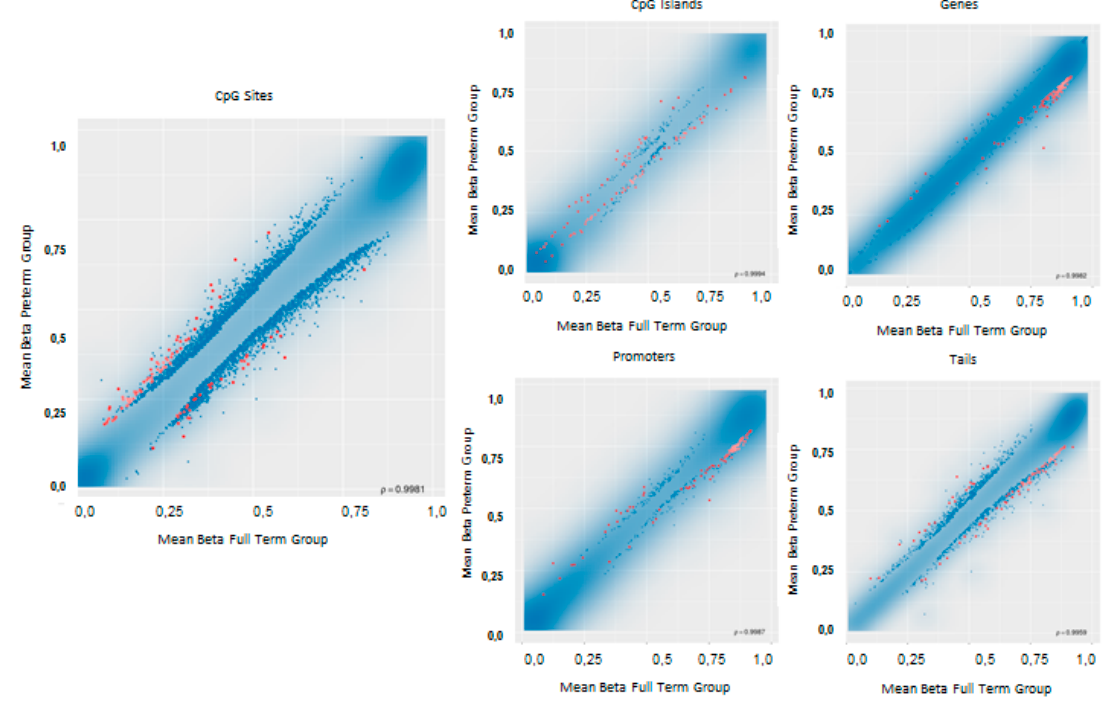
Figure 3. Scatterplot for differential methylation. The transparency corresponds to point density. If the number of points exceeds 2 × 10 6 then the number of points for density estimation is reduced to that number by random sampling. The 1% of the points in the sparsest populated plot regions are drawn explicitly (up to a maximum of 10,000 points). Additionally, the red dots represent significantly differentially methylated loci (according to the indicated criterion).